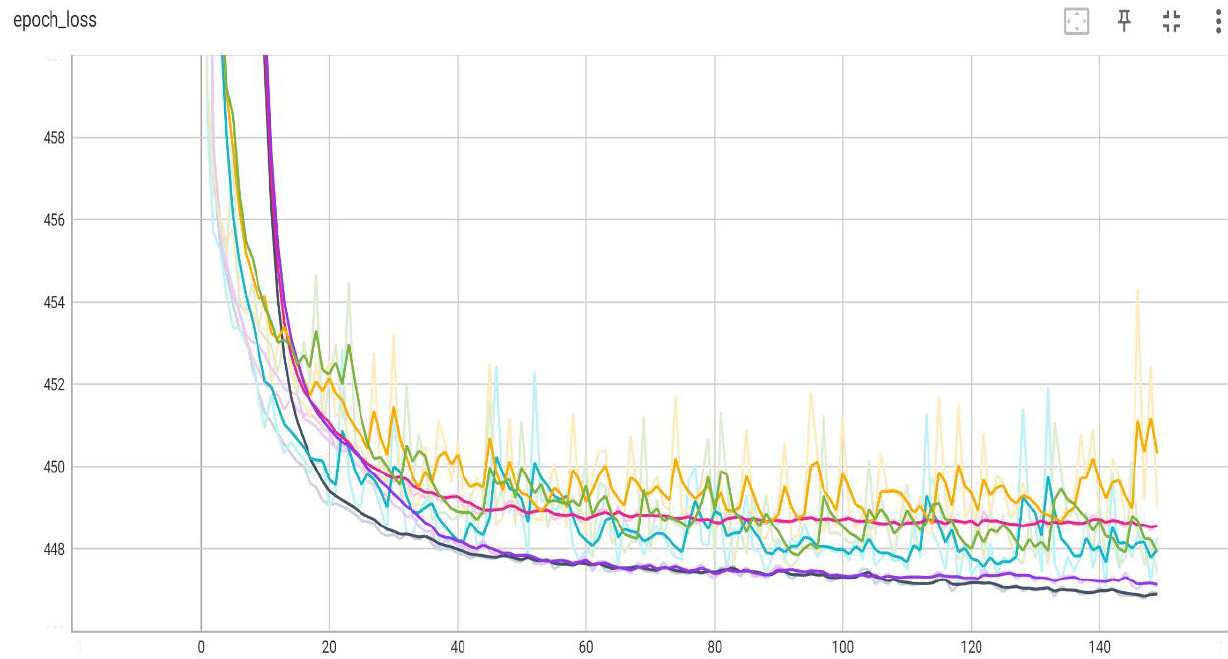
Figure 5. DNN Neural Network training evolution (from Tensorboard).